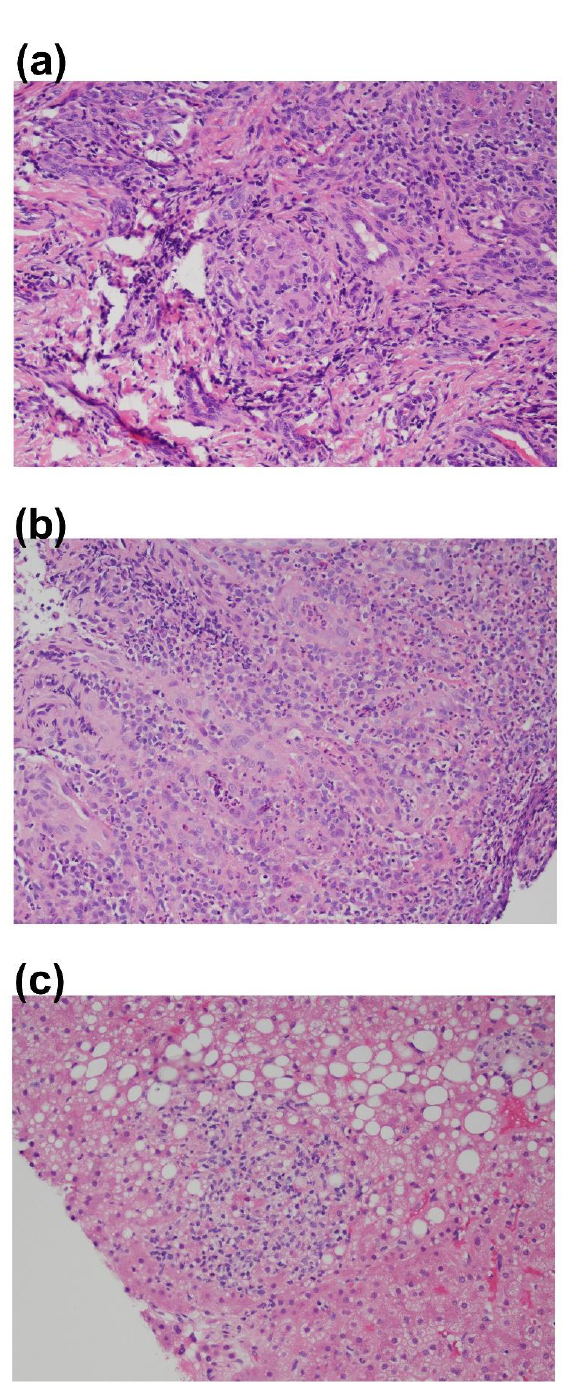
Figure 2. Histopathological evidence of granulomatous inflammation. ( a ) Mucosal ulceration with focal granulomatous inflammation, hyperparakeratosis, and acanthosis: image is focused on gingival tissue at the large zone of ulceration. Within fibrous connective tissue, a heavy mixed inflammatory cellular infiltrate that is predominantly neutrophils, lymphocytes, and histiocytes is seen. Widely scattered ill-defined clusters of histiocytes and multinucleated giant cells are noted. ( b ) Biopsy of transverse colon tissue showing large bowel mucosa with few granulomas. No significant crypt distortion. ( c ) Biopsy of the liver performed via needle biopsy. Hepatic architecture shows subtle distortion with nodular areas of widened alternating with areas of narrowed liver cell plates. No significant portal inflammation or interface hepatitis. Many of the portal areas lack a distinctive portal vein, and there are occasional foci of lobular inflammation. There is mild focal steatosis, involving less than 5% of